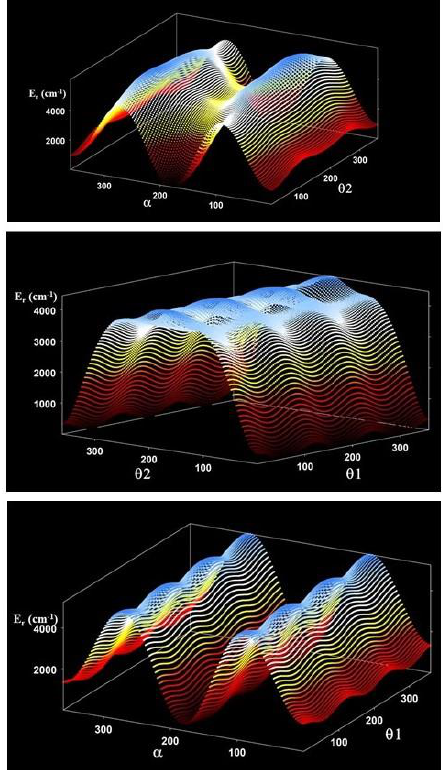
Figure 6. Two-dimensional cuts of the 3D potential energy surface of pyruvic acid.